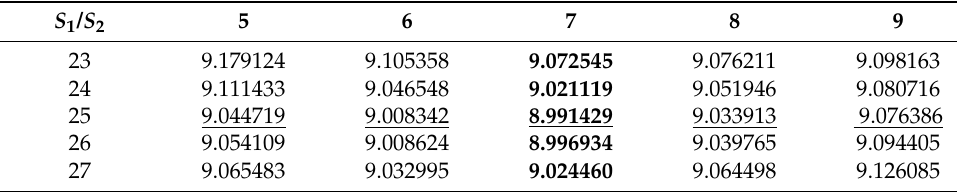
Figure 1. S 1 vs. S 2 on MTC . Table 1. Mean total cost rate as a function of S 1 and S 2